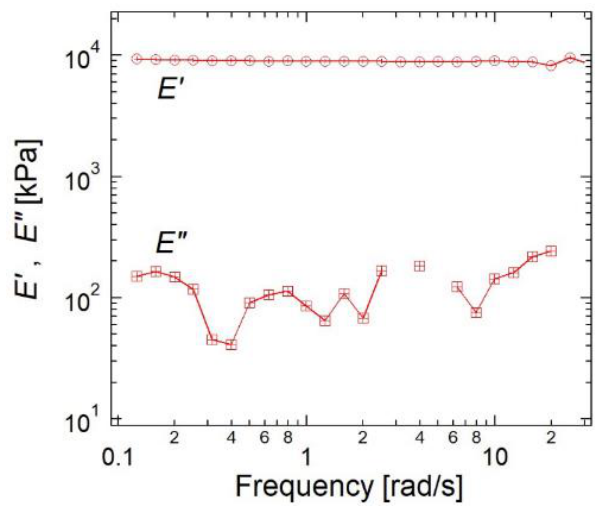
Figure 19. Frequency-dependence of E ’ and E ’’ for SR gel. Reprinted from [23] with permission from American Chemical Society.